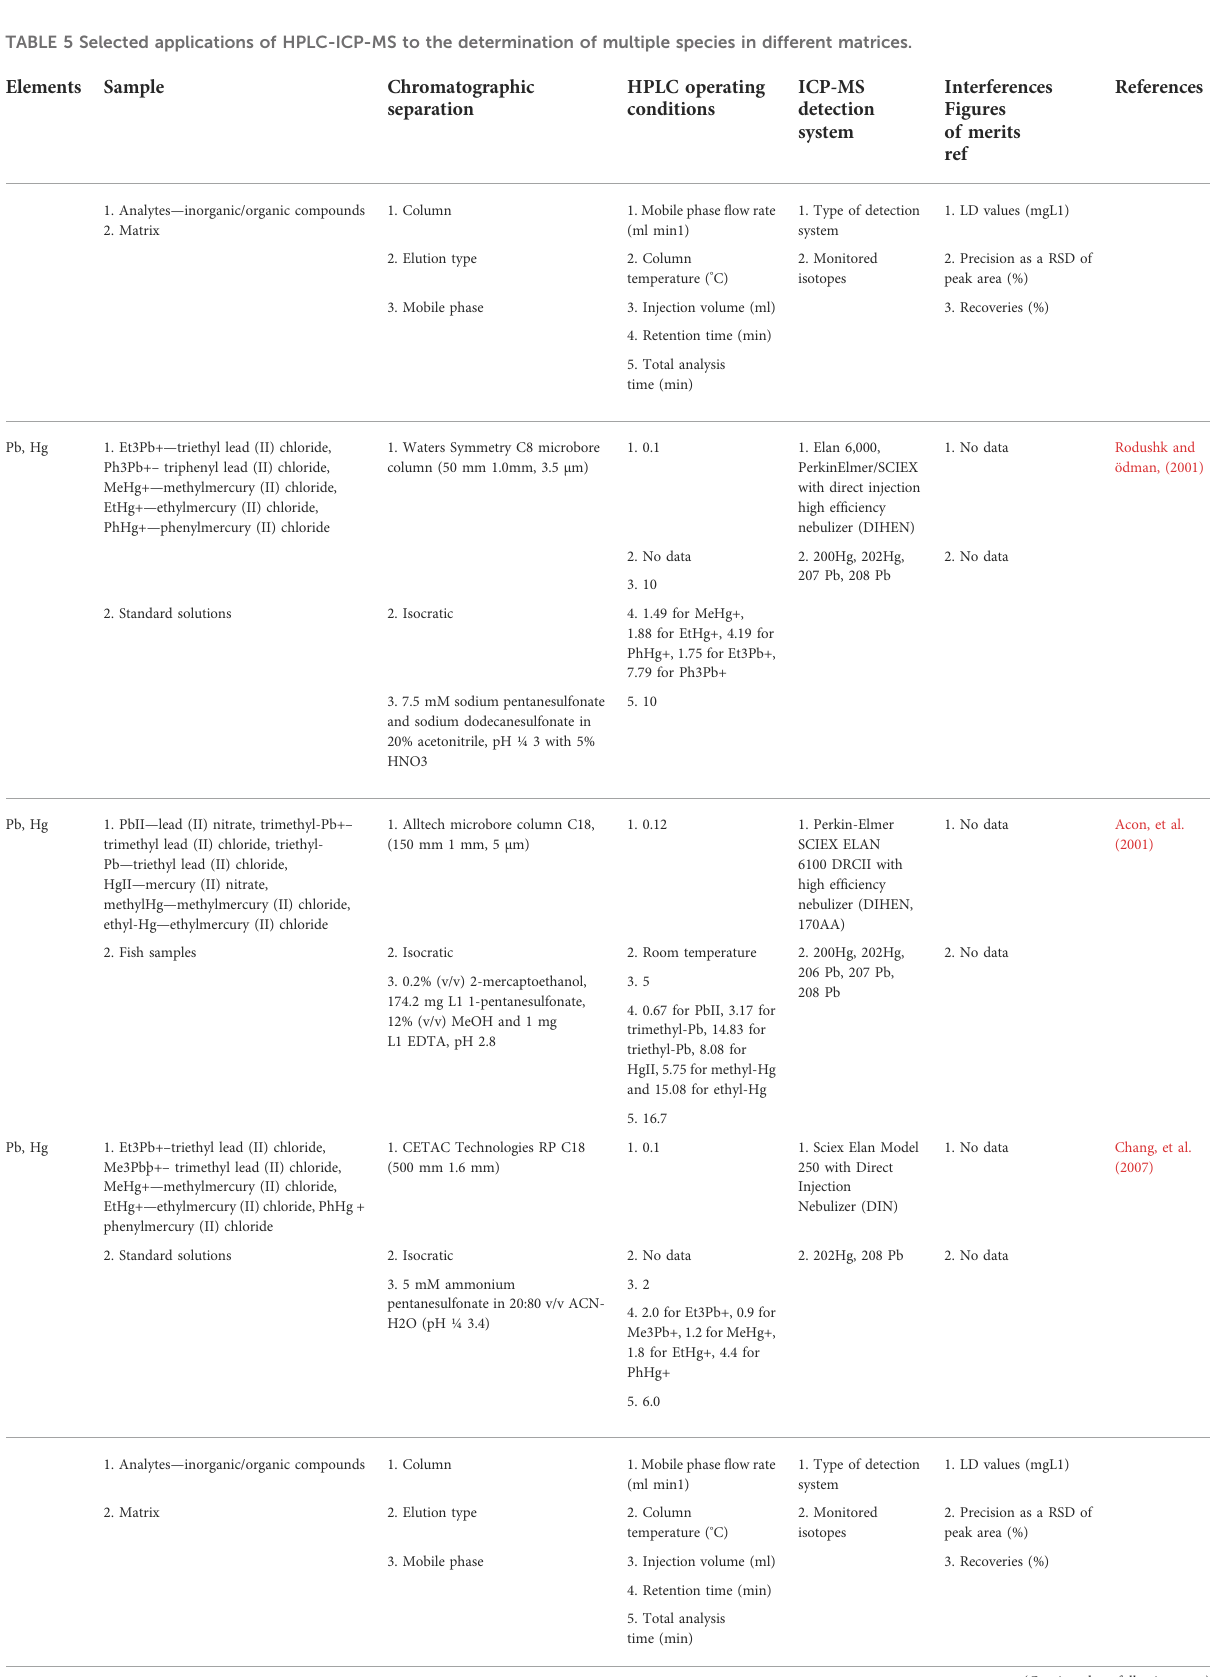
TABLE 5 Selected applications of HPLC-ICP-MS to the determination of multiple species in different matrices. Elements